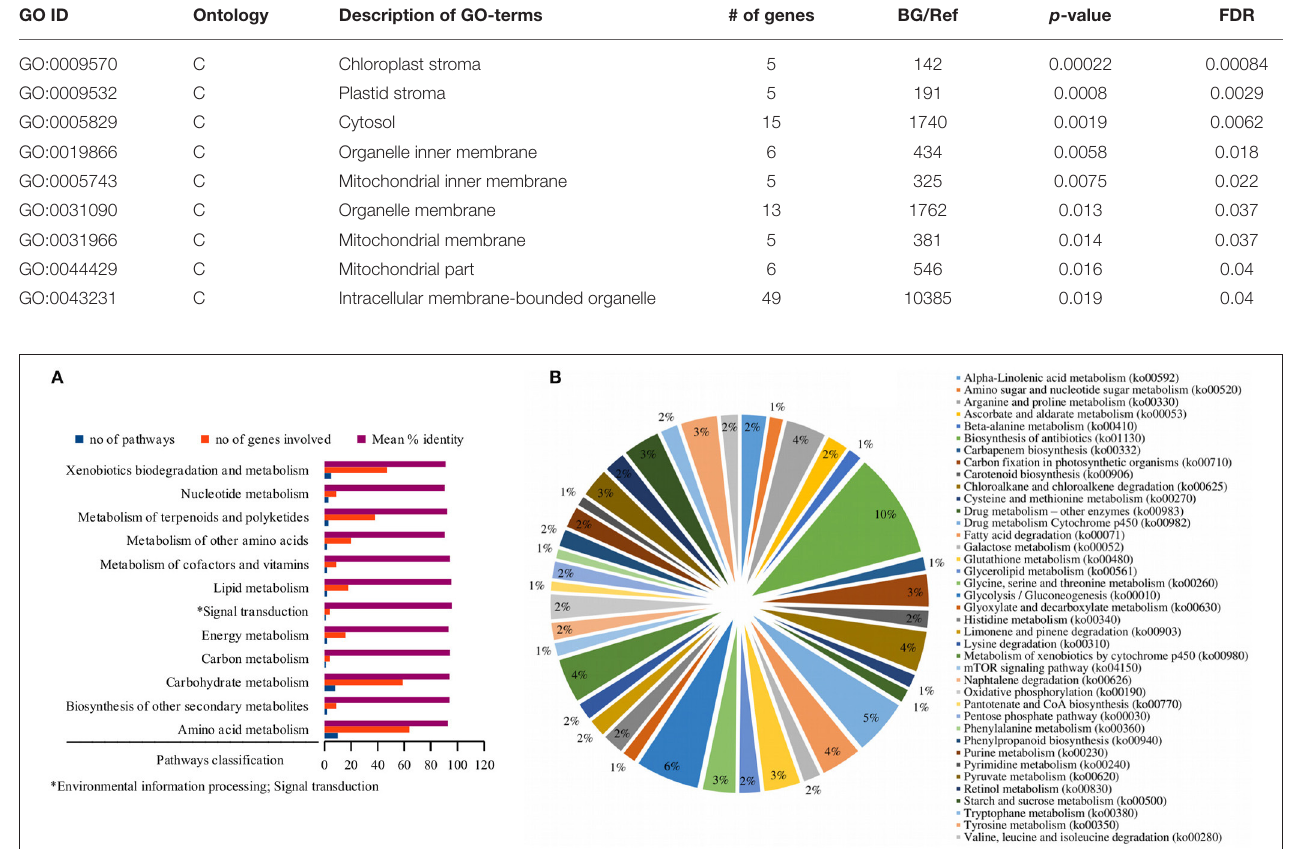
FIGURE 2 | Functional classification of the pathways. While the bar graph in this figure demonstrates the functional classes of the pathways based on specific type of metabolic class to which a particular pathway is grouped (A) , the pie chart shows the functional categories of the pathways based on the type and function of drought-related differentially expressed genes that were involved in the pathway (B) . The x-axis in (A) shows the functional classes of the pathways, while the y-axis shows the number of pathways, the genes involved and mean percent identity of pathways involved in the metabolic classes of the pathways. The distribution of the differentially expressed genes under stress condition among the pathways signifies the functional categories of the pathways in (B) . Information on the KEGG pathway annotations and enrichment analysis was based on the Blast2GO using 1e-10 e-value